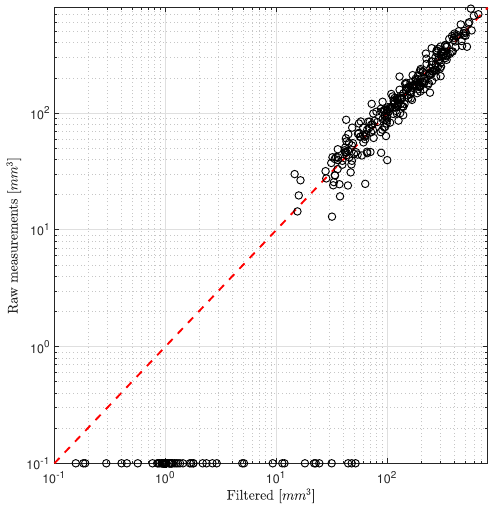
Figure 2. Difference between the raw and filtered